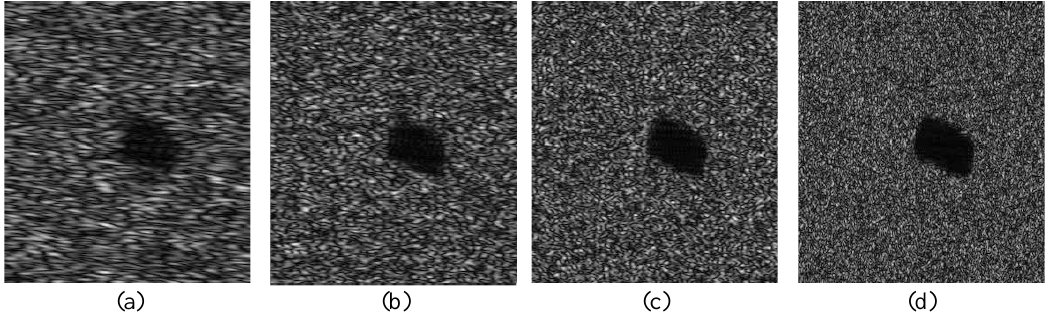
Figure 9. Effect of wavelength on shadow (horizontal is azimuth; vertical is range), ( a ) 5 GHz, ( b ) 10 GHz ( c ) 16 GHz, ( d ) 35 GHz.